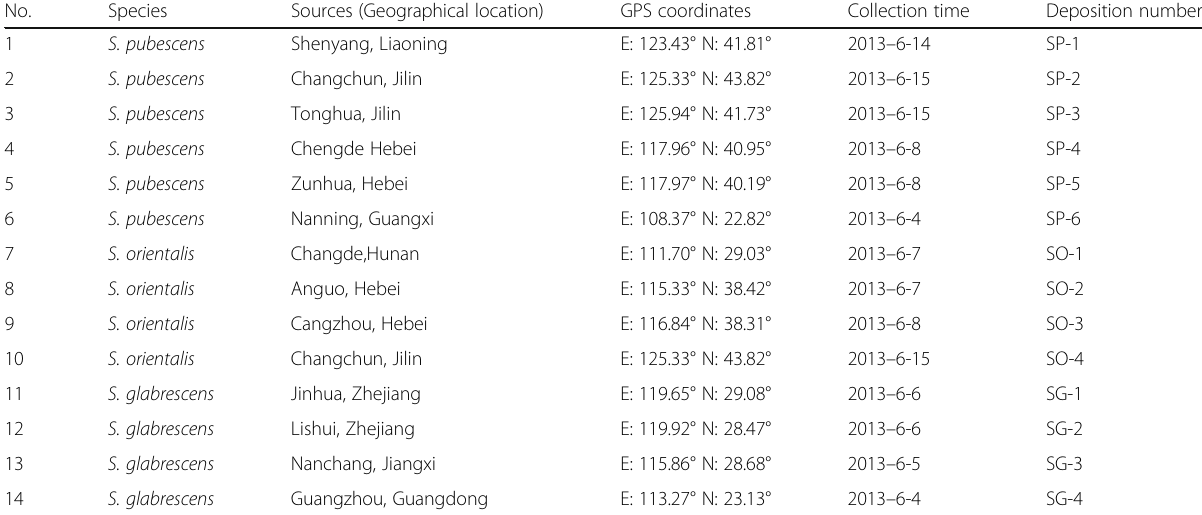
Table 1 Herbal sample information No. Species Sources (Geographical